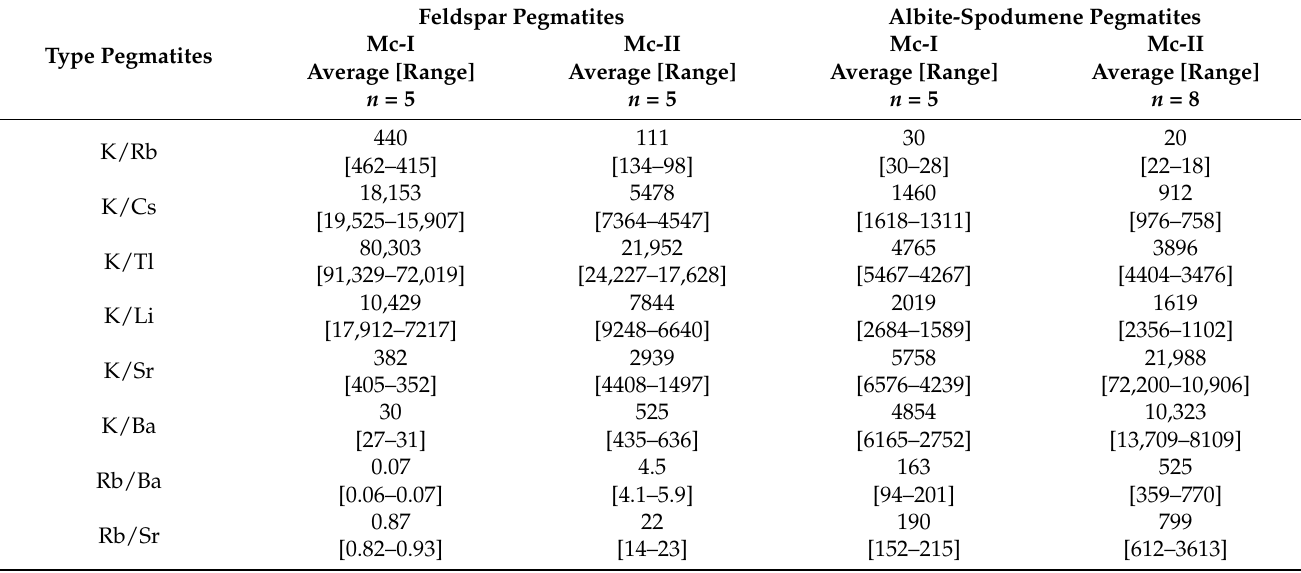
Table 5. Ratio of trace elements in K-feldspar. Determined by EMPA and